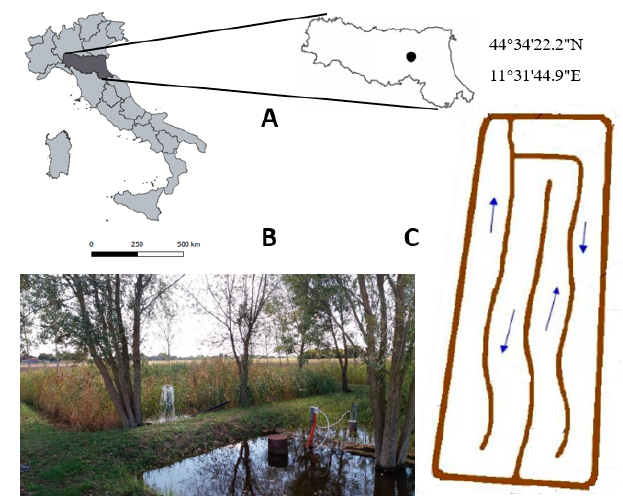
Figure 1. The location of the SFCW system in Emilia-Romagna region (Italy) ( A ), constructed wetland studied ( B ) and its hydraulic scheme (arrows show the direction of the water flow) ( C ).